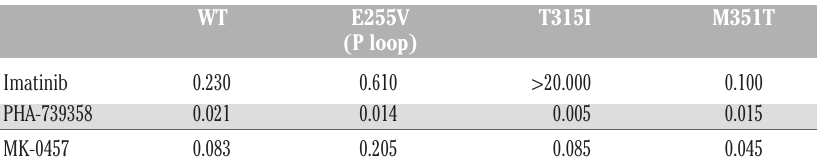
Table 4. Comparison between the binding affinity of imatinib and of the aurora kinase inhibitors PHA-739358 and MK-0457 for wild-type and drug-resistant Abl variants. Adapted from